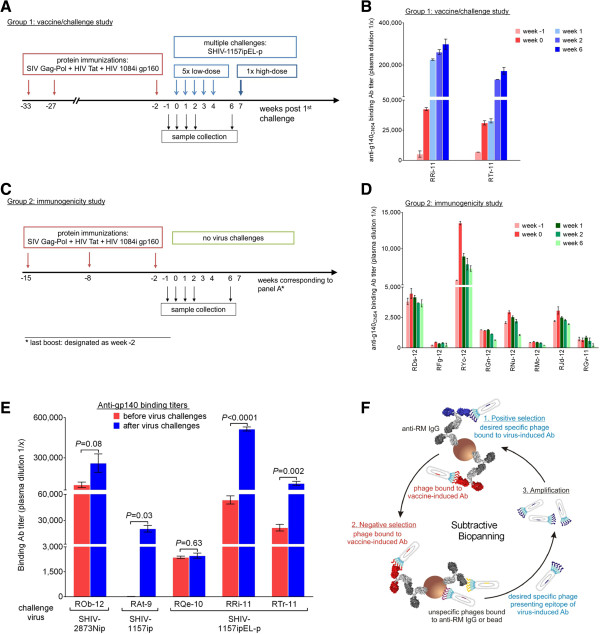
Anti-Env Ab responses in vaccinated RMs before and after virus challenge. A. Time line of vaccine/challenge study [12]. In red, immunization phase; in blue, challenge phase. Plasma samples were collected at weeks −1, 0, 1, 2 and 6. B. Quantitative ELISA to determine Env-specific Ab titers in two vaccine-protected RMs. In red, time points post 3rd immunization and pre-challenge; in blue, time points post challenge. C. Time line of immunogenicity study (unpublished). The last protein immunization was designated as week −2, so that the subsequent weeks would correspond to the study in (A). D. Quantitative ELISA to determine Env-specific Ab titers in eight vaccinated, but not challenged RMs. In red, 1 or 2 weeks post 3rd immunization; in green, subsequent time points. E. The gp140CN54-specific Ab titers were compared before and after live-virus challenges in five completely protected vaccinees. The challenge viruses used are indicated. Height of each bar, average titer from three independent assays; error bars, standard error of the mean (SEM). P values are shown (P < 0.05 was considered significant). F. Subtractive biopanning. Three rounds of selection were performed to identify Ab epitopes linked to live-virus exposure. Each round of selection consists of (1) positive selection, (2) negative selection and (3) amplification of the selected phages. Light gray, the Fc portion of all Abs. Dark gray, Fab portion of anti-RM IgG immobilized onto paramagnetic beads via the Fc. Positive selection used week 7 plasma from a protected animal. In dark blue, Fab portions of the live-virus induced Abs and the corresponding phages. Positively selected recombinant phages were counter-selected with plasma from the same vaccinee but collected at week 0 (containing vaccine-induced Abs only). In red, Fab portions of negative selector Abs and the corresponding bound phages. Purple or yellow phages, unspecific phages bound to anti-RM Ab or beads, respectively.